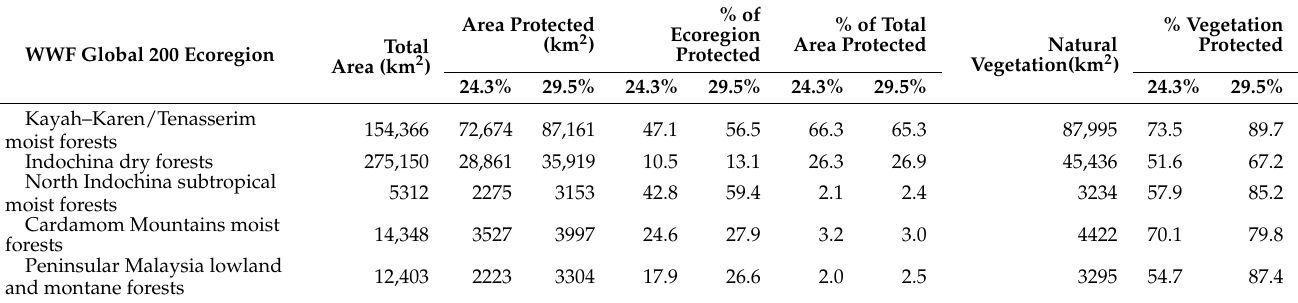
Table 5. Representation of the five WWF Global 200 ecoregions present in Thailand in protected areas currently (24.3%) and after expansion